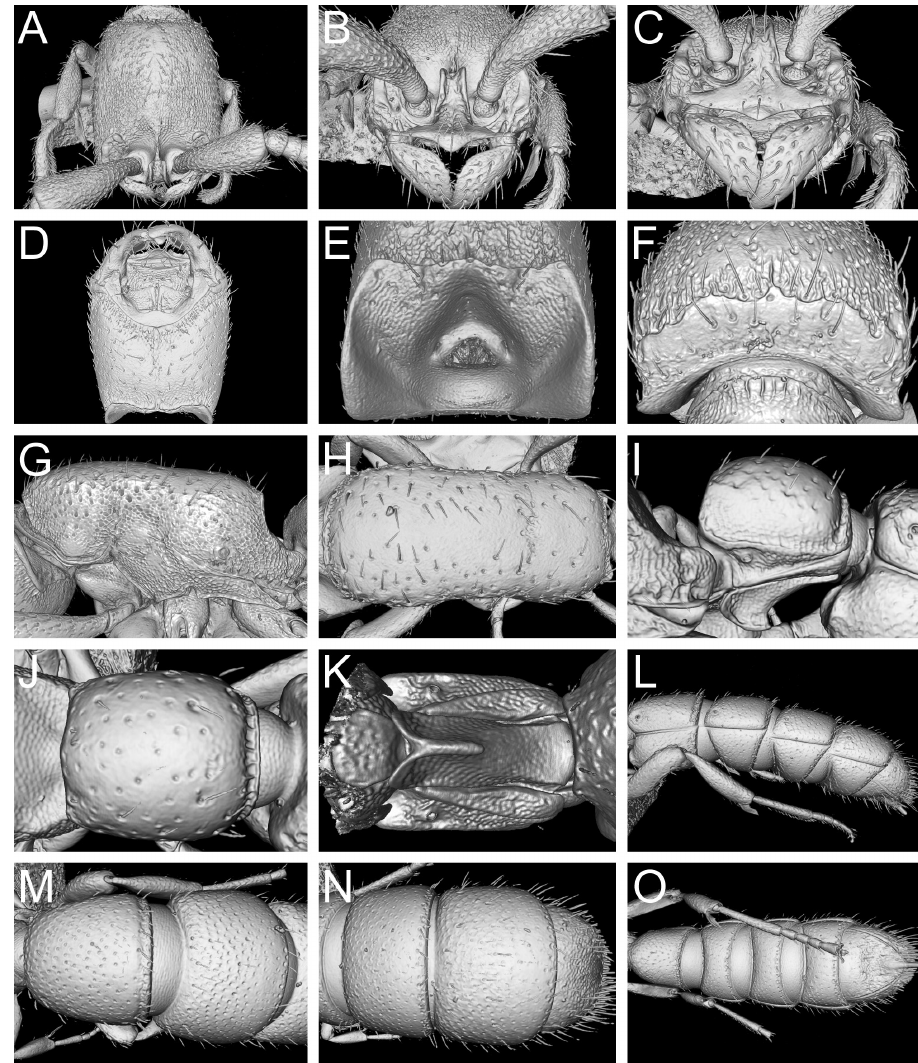
Figure 12. Shaded surface display volume renderings of 3D models of Zasphinctus wilsoni sp. n. holotype worker (MCZ-ENT-00512764). A Head in full-face dorsal view B Head in anterodorsal view C Anterior ce- phalic dorsum and mandibles in anterodorsal view D Head in ventral view. E Occiput in posterior view (ven- tral head facing upwards) F Head in posterodorsal view G Mesosoma in profile H Mesosoma in dorsal view I Abdominal segment II (petiole) in profile J Abdominal segment II (petiole) in dorsal view K Abdominal seg- ment II (petiole) in ventral view L Abdominal segments III–VII in profile M Abdominal segments III and IV in dorsal view N Abdominal segments V–VII in dorsal view O Abdominal segments III–VII in ventral